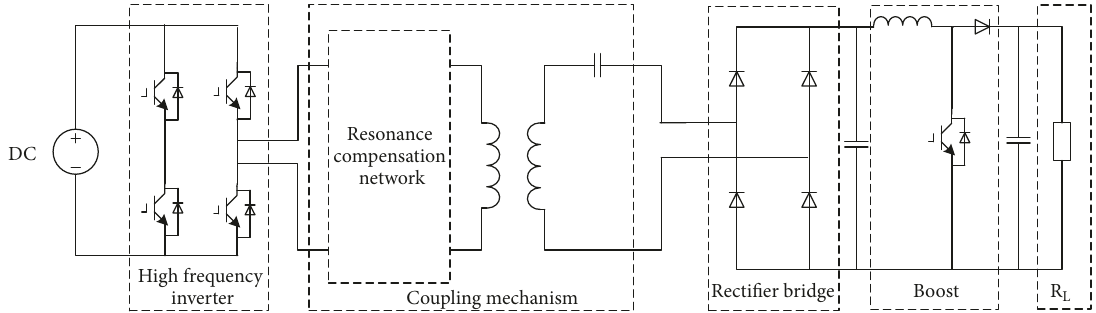
Figure 1: Structure of IPT system applied to urban rail transit.